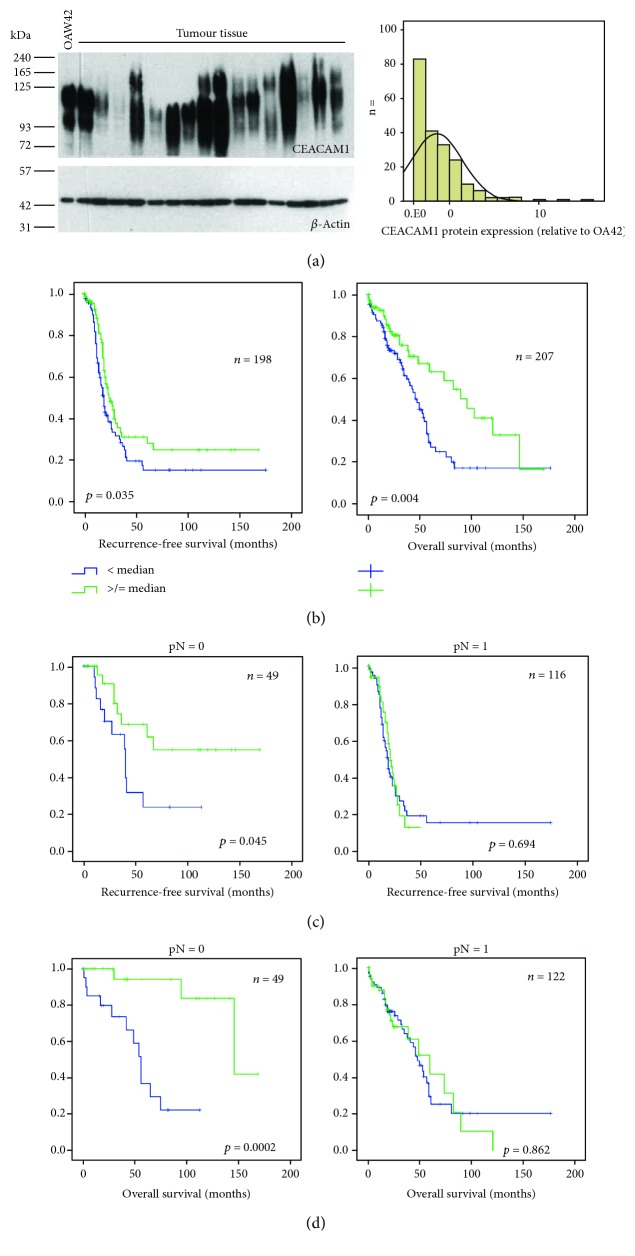
CEACAM1 protein expression in clinical tumor tissue samples. (a) Representative Western blot results of CEACAM1 expression in ovarian carcinomas (left) and distribution of the relative expression within the cohort (right). Protein extract from the ovarian cancer cell lines OAW42 was included in each gel as an internal control. (b) Kaplan–Meier analysis showing correlations of high CEACAM1 protein expression with longer recurrence-free survival and overall survival. (c, d) Kaplan–Meier analysis and log-rank tests, stratified for tumors with (pN = 1) and without (pN = 0) nodal involvement. High CEACAM1 expression correlated significantly with shorter recurrence-free survival and overall survival only in patients without nodal involvement.